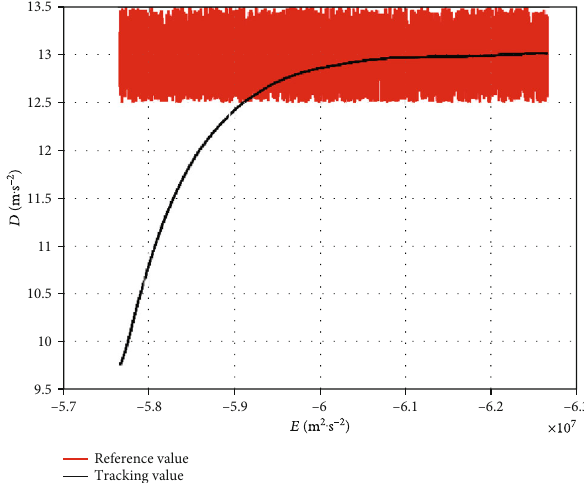
Figure 4: Drag acceleration command tracking process with ξ = 2 and ω = 5 e − 6 n